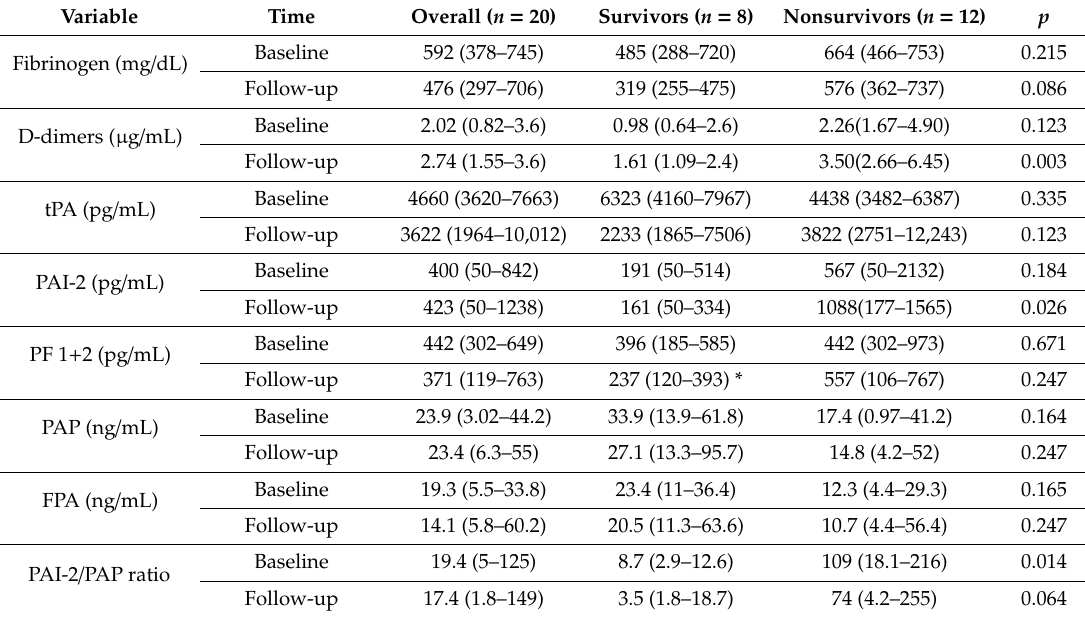
FPA: fibrinopeptide A; PAI: plasminogen activator inhibitor; PAP: plasmin–antiplasmin complex; PF: prothrombin fragment; tPA: tissue plasminogen activator. Within-group di ff erence between follow-up and baseline: * p = 0.025. Data are given as median (interquartile